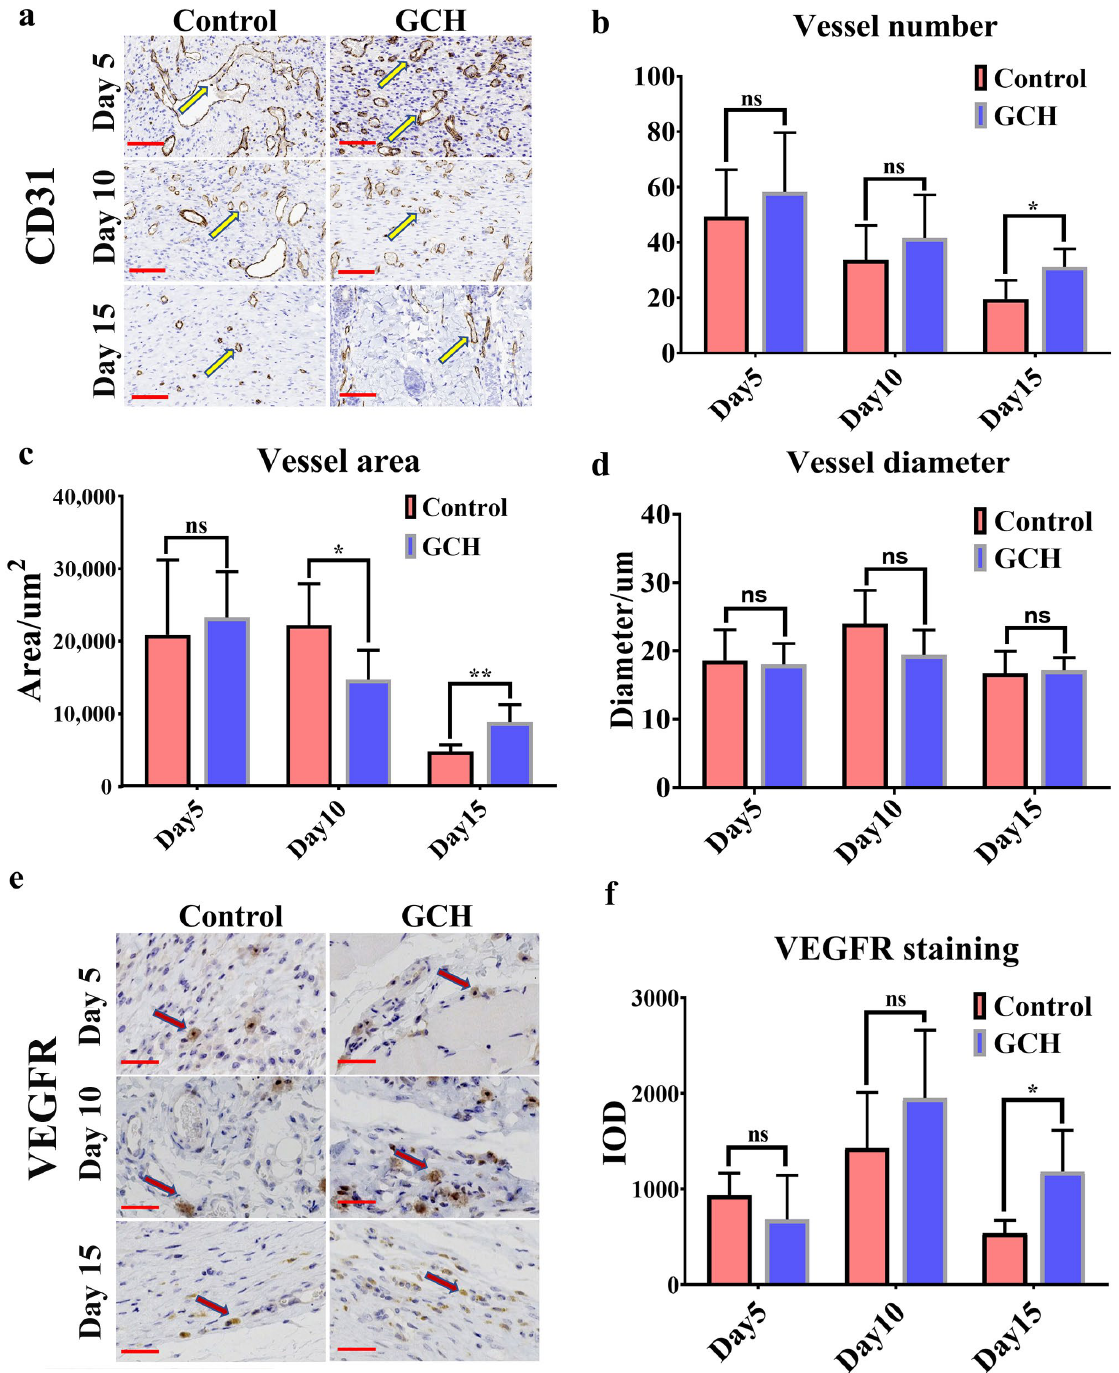
Figure 6. IHC staining of CD31 and VEGFR for the regenerated skin tissues. ( a ) Representative images of skin tissue sections after IHC staining with CD31 on the 5th, 10th, and 15th day of each group; the brown tube indicates vascular tissue (yellow narrow arrows). Scale bar: 100 μm. ( b ) Quantified analysis of the vessel number for each time. ( c ) Quantified analysis of the vessel diameter for each time. ( d ) Quantified analysis of the vessel area for each time. ( e ) Representative images of skin tissue sections after IHC staining with VEGFR at designed time intervals for each group; brown-colored cells indicate positive (red narrow arrows). Scale bar: 50 μm. ( f ) Quantified analysis of VEGFR IOD for each time. (Statistical significance was calculated via Student’s t -test. ns: no statistical difference, * p < 0.05, ** p < 0.01.) All data are presented as mean ±